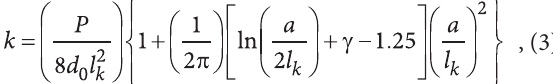
Fig. 4. Foundation modulus backcalculated by AREA method